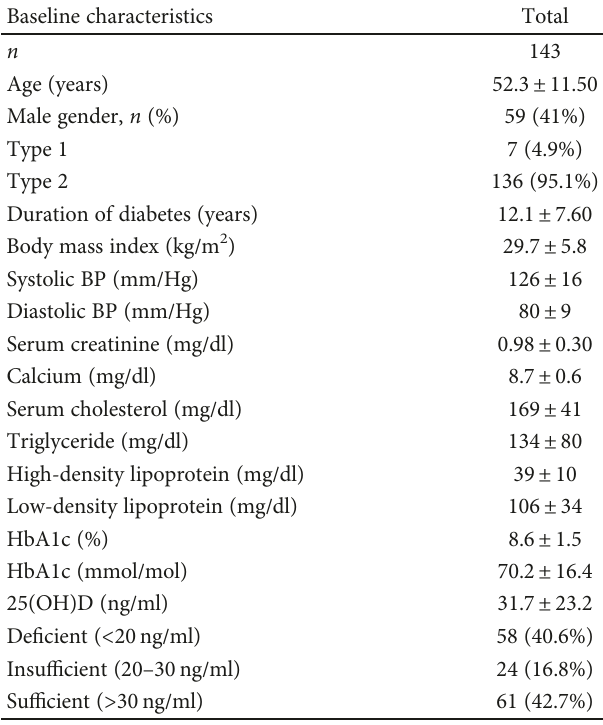
Table 1: Baseline characteristics of